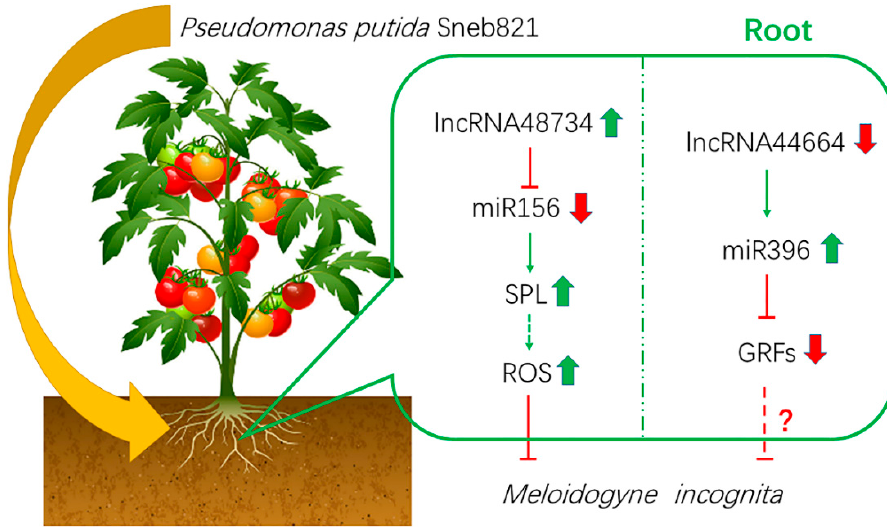
Figure 7. Model of biocontrol bacteria induces tomato resistance to M. incognita . Arrows indicate positive regulation, and blunt-ended bars indicate inhibition. A line does not necessarily represent unique or direct regulation. A question mark refers to unverified regulation under M. incognita stress.